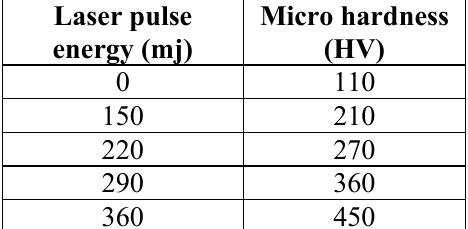
Table 2: Relation between laser pulse energy and micro hardness.